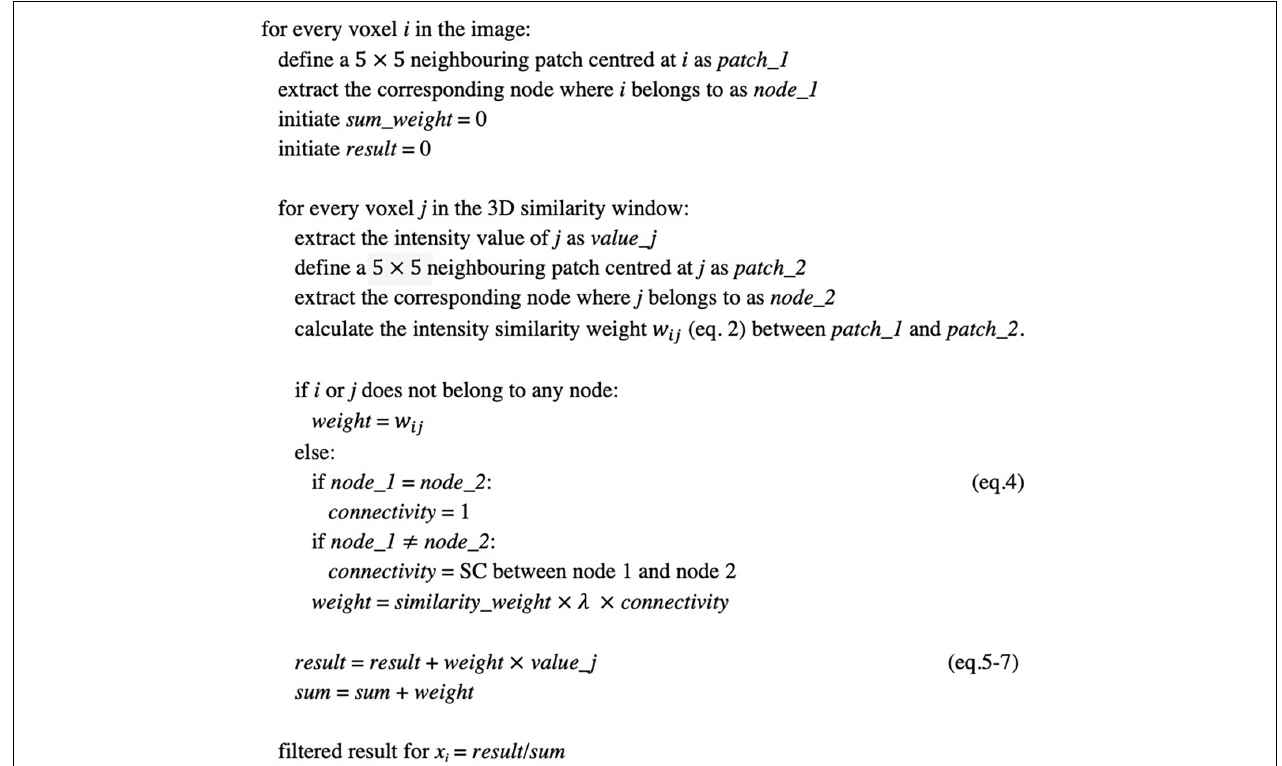
FIGURE 3 | Pseudocode for implementing the connectome-based non-local means (CONN-NLM)